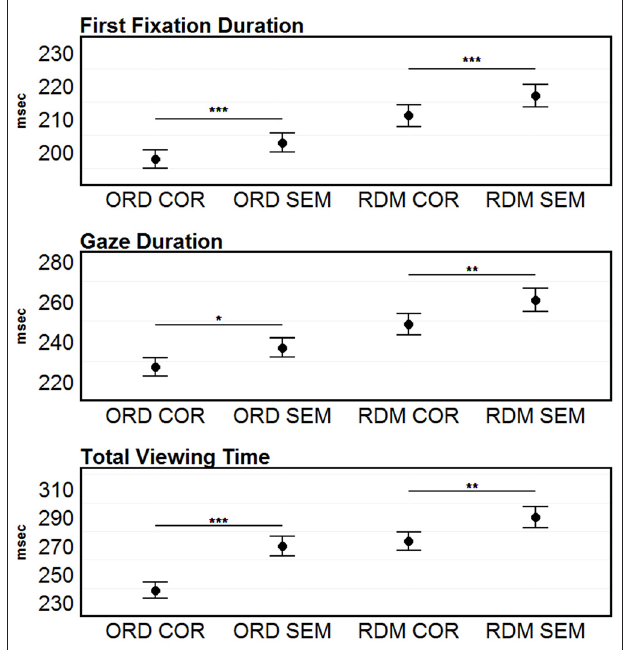
FIGURE 1 | Eye movement (EM) results. First-fixation durations (FFDs), gaze durations (GDs) and total viewing time (TVT) on the target words. Error bars represent 95% confidence intervals. Significant differences between the correct and the semantically incorrect condition (within the ORD and COR conditions) are marked with asterisks: *** p < 0.001; ** p < 0.01; * p < 0.05.